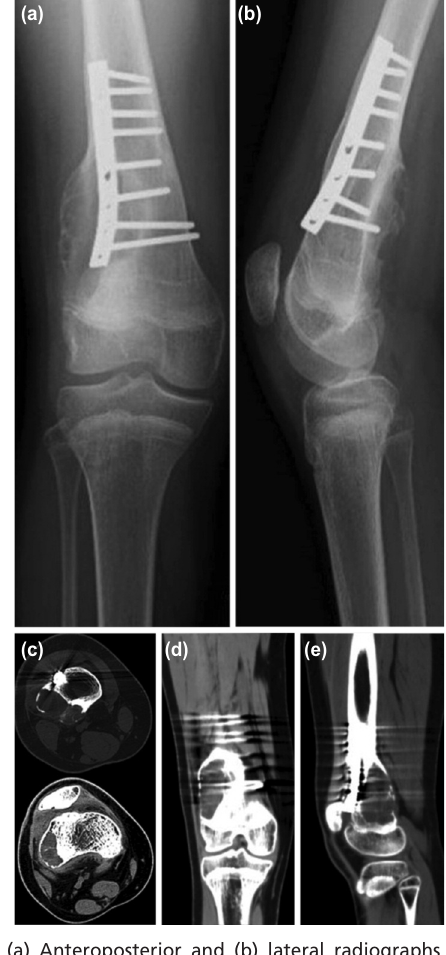
(a) Anteroposterior and (b) lateral radiographs of the Fig. 2: right knee at the 2nd year follow-up after femoral derotational osteotomy. Radiographs show a large bone cyst on the distal lateral portion of the right femur. (c) Axial, (d) coronal and (e) sagittal computed tomography scan images of the right knee showing location and expansion of the